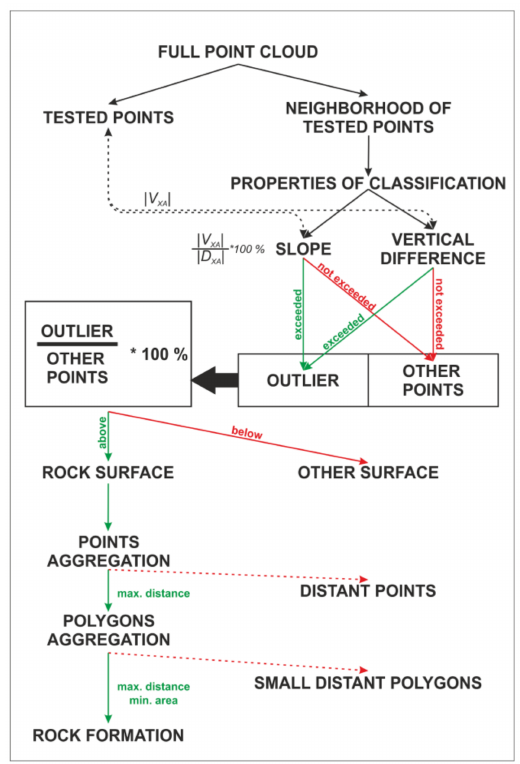
Figure 3. Process of searching for rock formations. V XA means vertical difference and D XA means horizontal difference between tested points X and